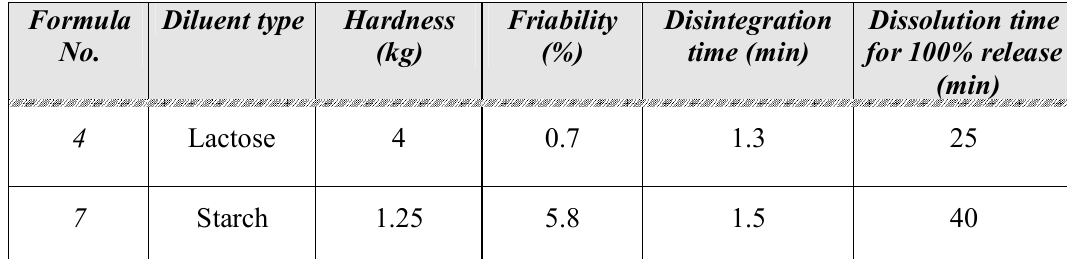
Table (3): Effect of binder concentration on the physical properties of captopril tablets of suggested formulas 4,5, and 6.